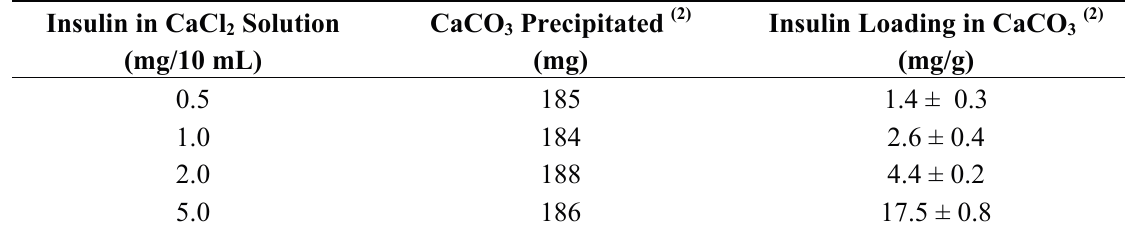
microspheres (1) . 3